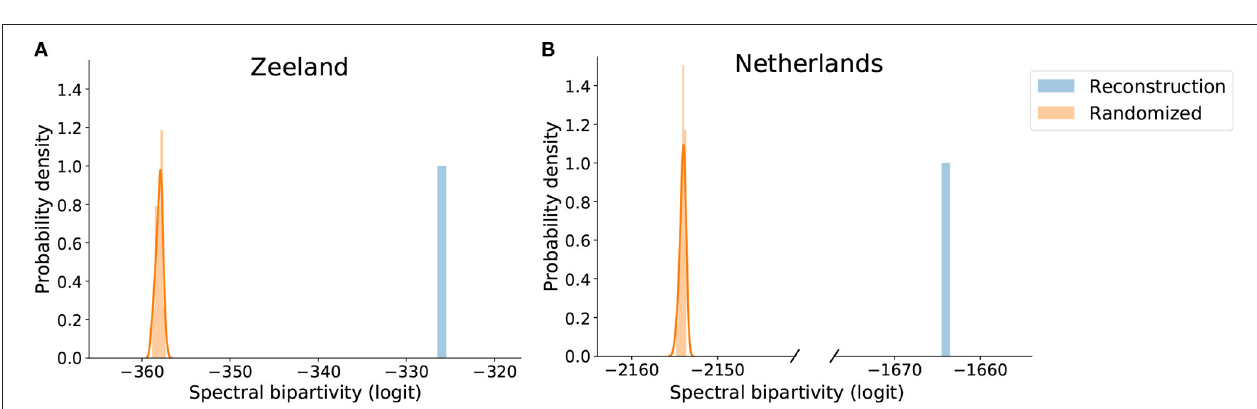
FIGURE 4 | Value of logit-transformed spectral bipartivity of reconstructed (A) Zeeland and (B) Netherlands production networks and the comparable distributions of their randomized